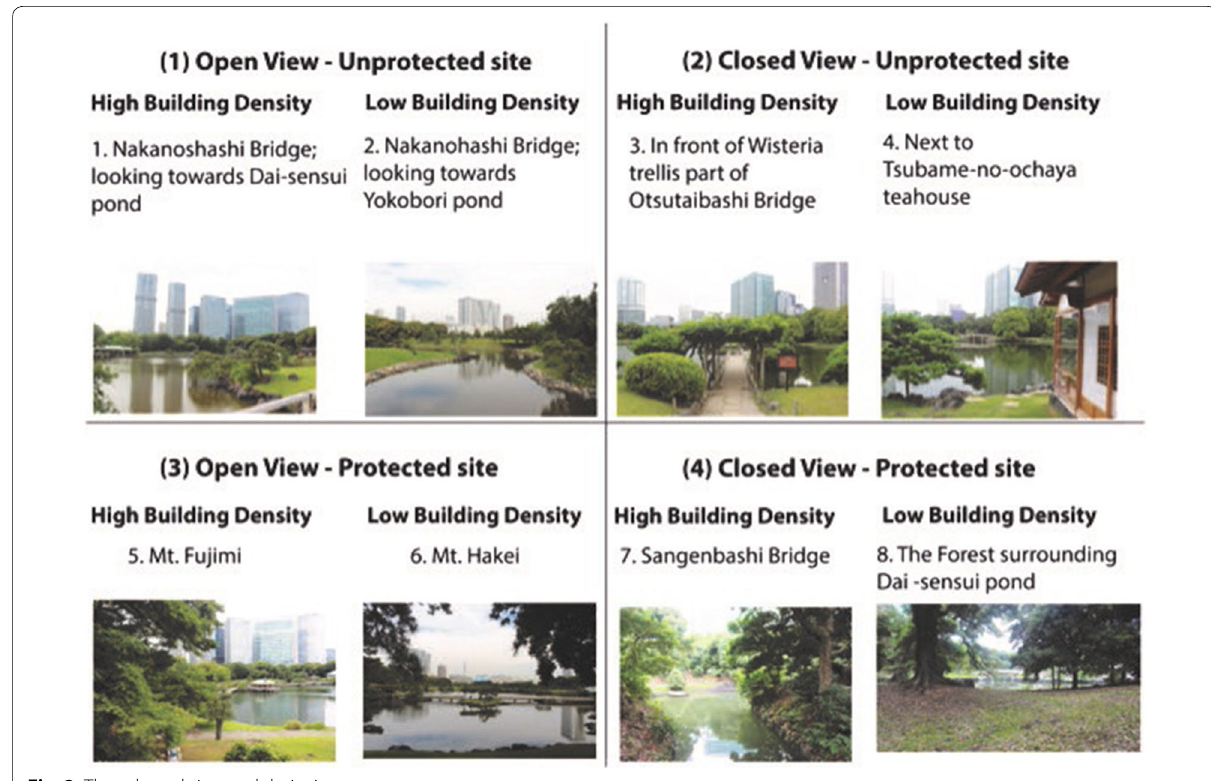
Fig. 2 The selected sites and their views